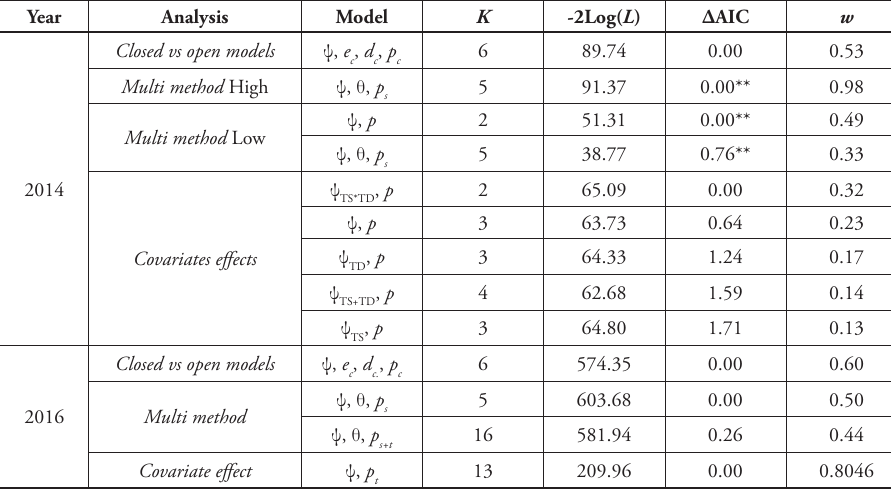
Table 4. Summary of plausible models (ΔAIC < 2) obtained by model selection statistics for Cerambyx cerdo . Detection/non-detection data were recorded during the two years’ study carried out at Bosco della Fontana in 2014 and